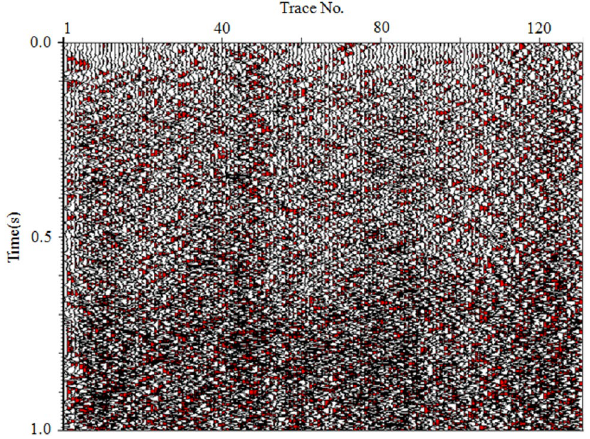
Fig. 12 Difference plot between Figs. 4 and 11. High-frequency com- ponents of the coherent signal are